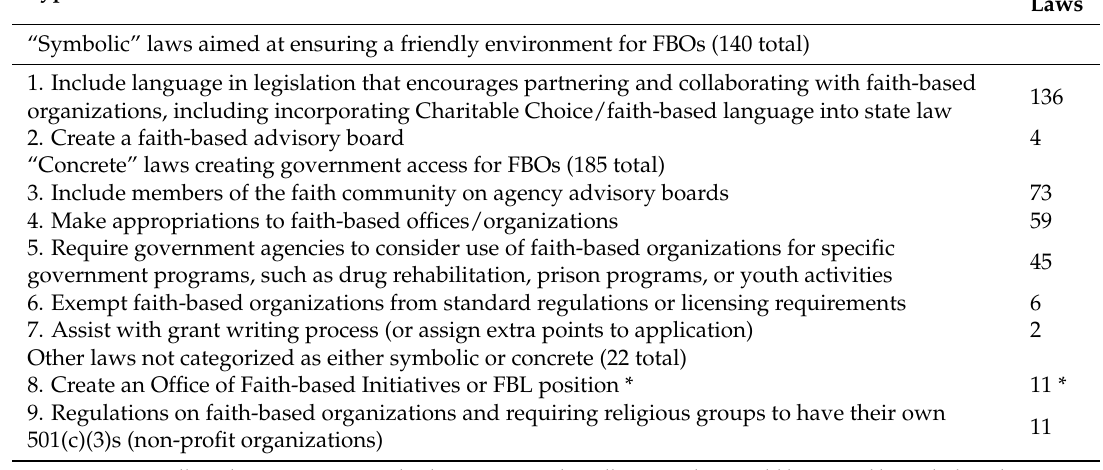
Table 1. Type and number of Faith-based Initiative laws benefiting faith-based organizations. Type of